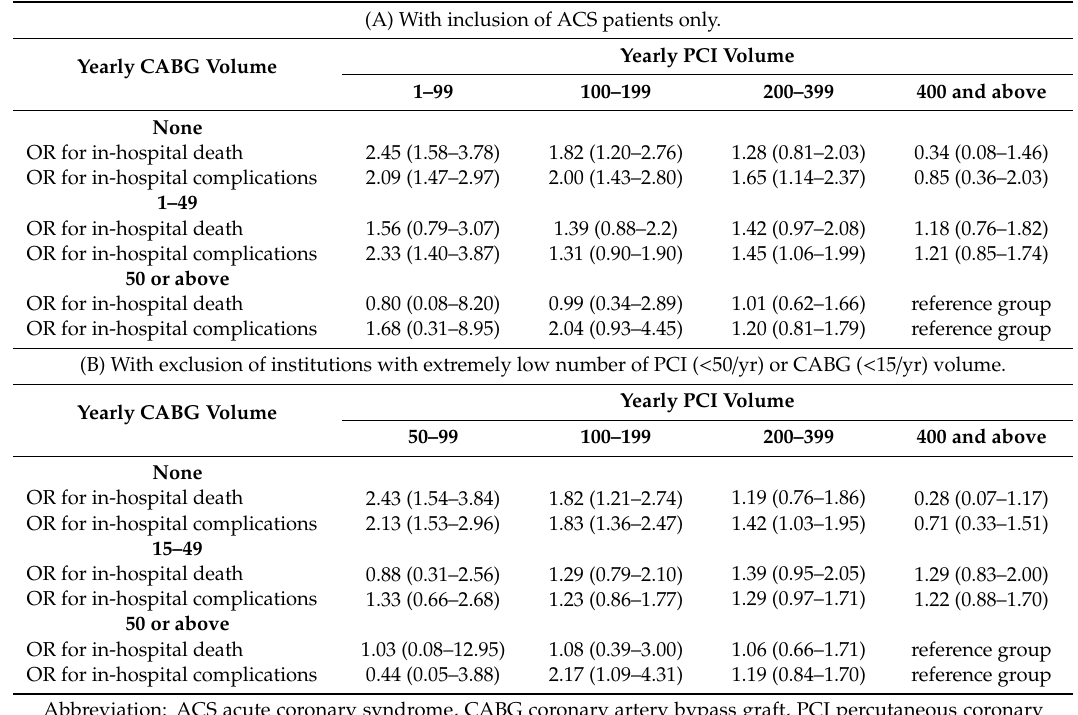
Table 3. Adjusted in-hospital PCI outcomes by its volume for patient subgroup that presented with acute coronary syndrome (ACS) ( A ) or with exclusion of institutions with extremely low volume of PCI ( < 50 cases / yr) or CABG ( < 15 cases / yr) ( B ) subcategorized by absolute CABG volume (none, less than 50, 50 or above).